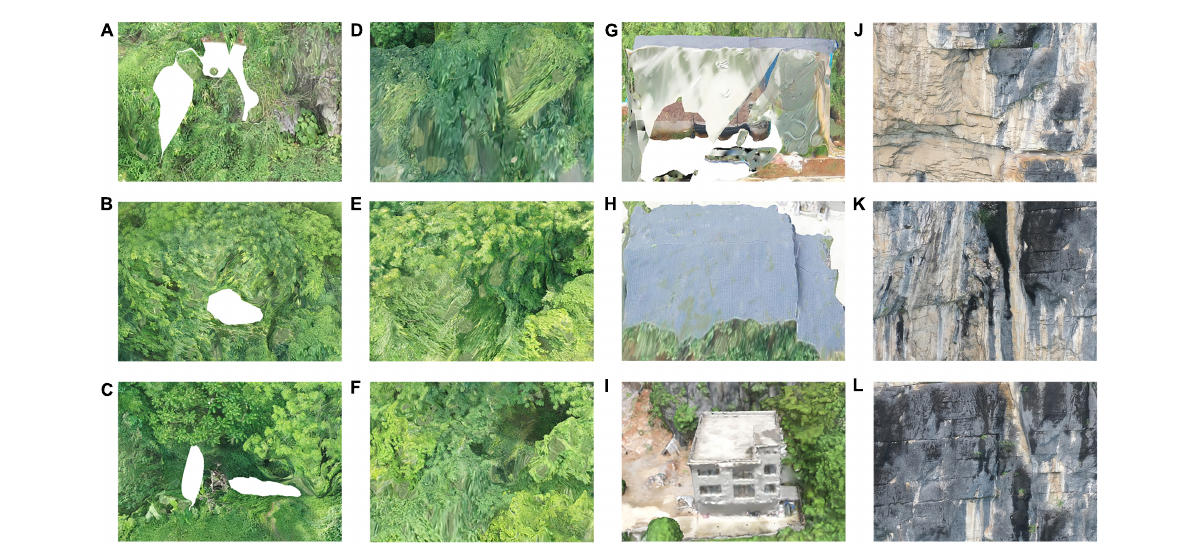
FIGURE8 (A–C) Holes of vegetation in the lower part of cliff model. (D–F) Distortion of high vegetation cover on model surface. (G–I) Holes of house building in the lower part of cliff model. (J–L) Cliff rock without vegetation cover of the